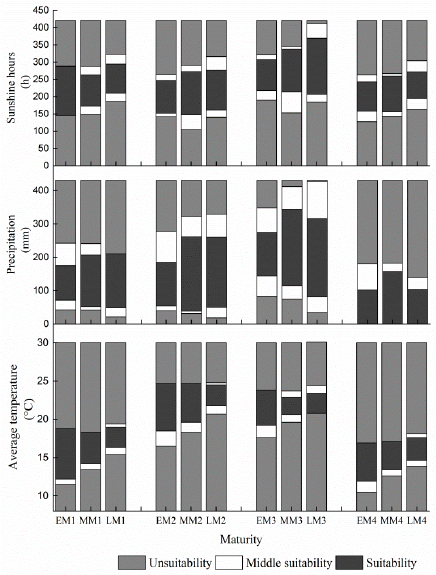
Figure 5. Yield-based refinement of factor suitability (period 1 from germination to jointing, period 2 from jointing to tasseling, period 3 from tasseling to milking, period 4 from milking to maturity; EM: early maturity, MM: middle maturity, LM: late maturity). Atmosphere 2019 , 10 , x FOR PEER REVIEW